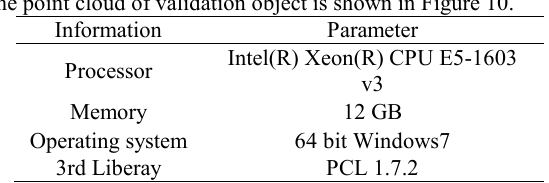
Table 3. Information of the used